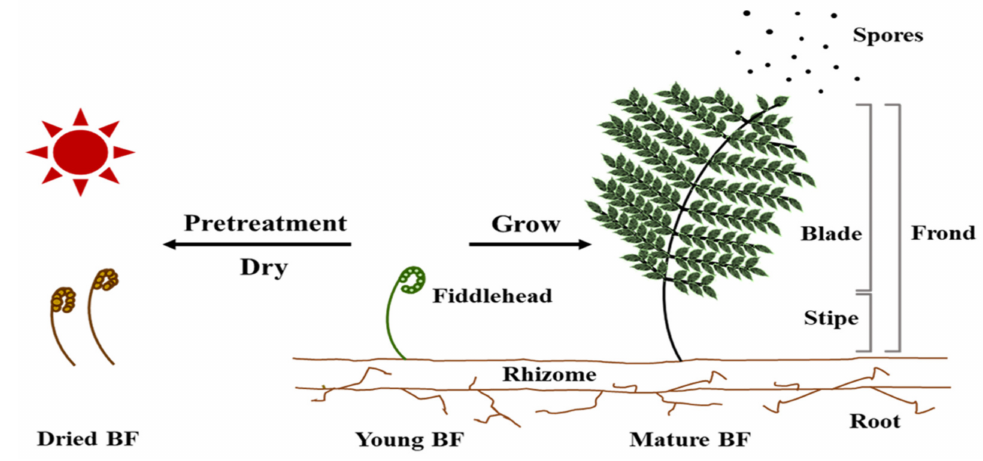
Figure 1. The structure and fate of the bracken fern (BF; adapted from [5]).